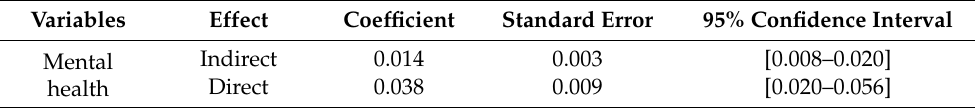
Table 3. Mediation effect test results (bootstrap method).